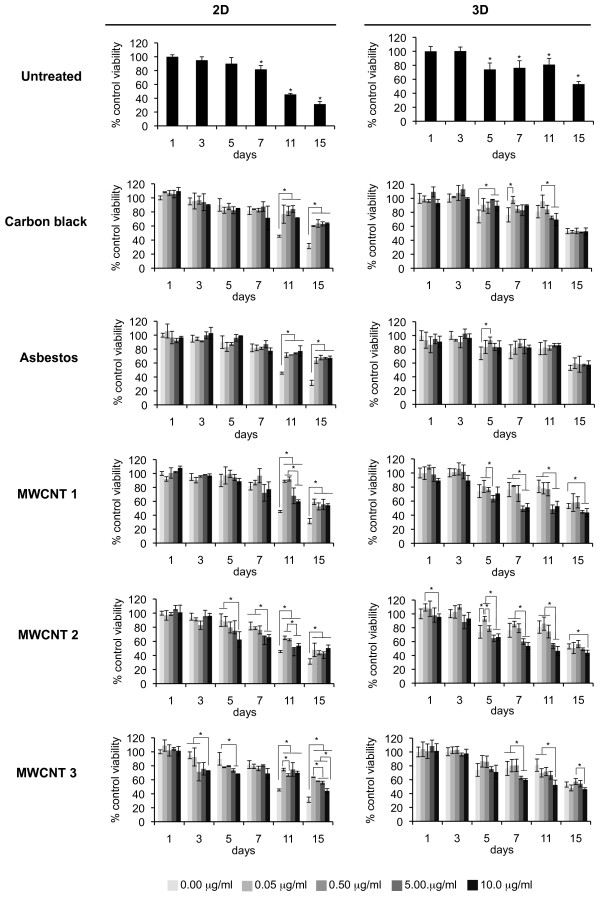
Macrophage survival in 2D and 3D cultures. 2D and 3D BMDM cultures were exposed to 0.05 μg/ml (0.038 μg/cm2), 0.5 μg/ml (0.38 μg/cm2), 5 μg/ml (3.8 μg/cm2) and 10 μg/ml (7.6 μg/cm2) of carbon black, asbestos fibers or MWCNTs. Total DNA content was used as a measure of cell number. Bars represent the mean ± SD of three separate determinations, *p < 0.05.